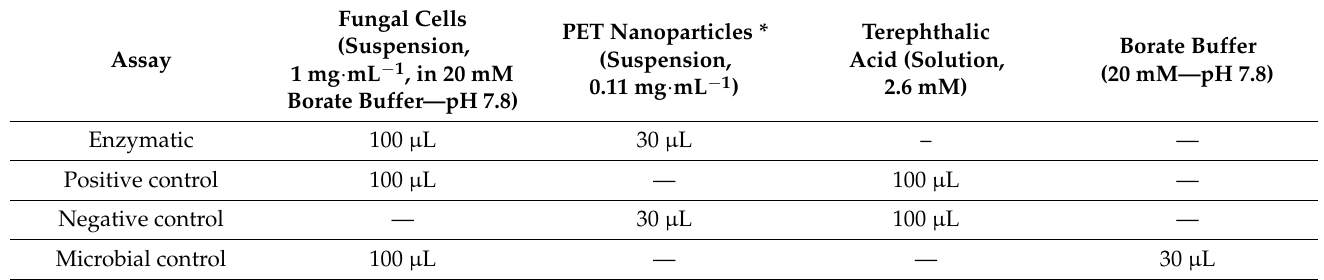
Table 1. Components per assay for analyses with PET